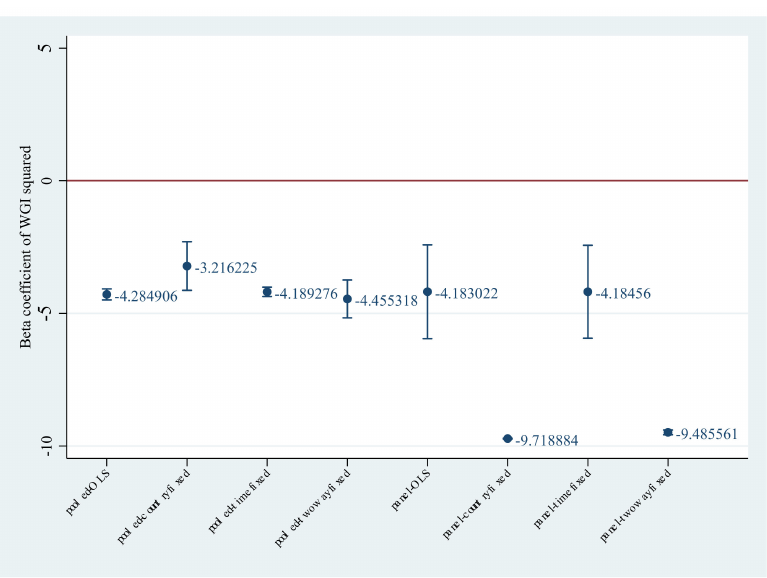
Figure 3. The beta coefficients of WGI squared. Notes: Horizontal axis is labeled as the regression models corresponding with columns (1) to (8) in Table 4. Vertical axis shows the value of beta coefficients of WGI